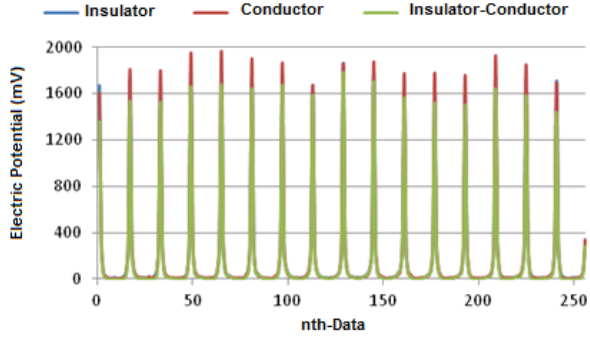
Figure 7: Electrical potential data of